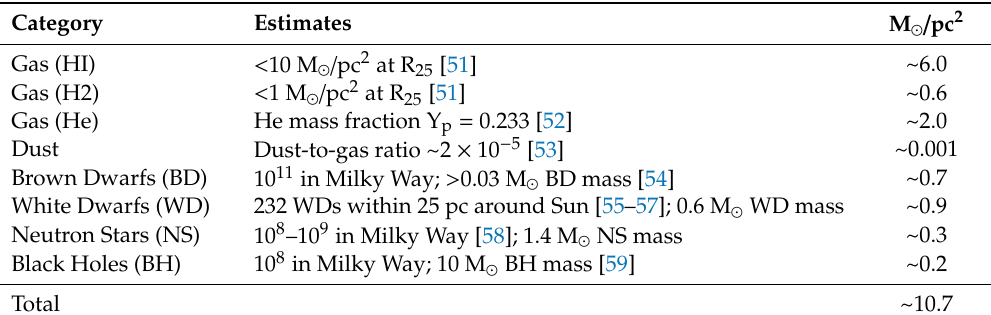
Table 1. Summary of contemporary estimates for various classes of low-luminosity baryonic mass. Estimates for brown dwarfs (BD), white dwarfs (WD), neutron stars (NS), and black holes (BH) assuming surface mass density ~27 M (cid:12) / pc 2 , an average density across our sample at R 27 (see Figure 11), and applying consistent global mass ratios to respective